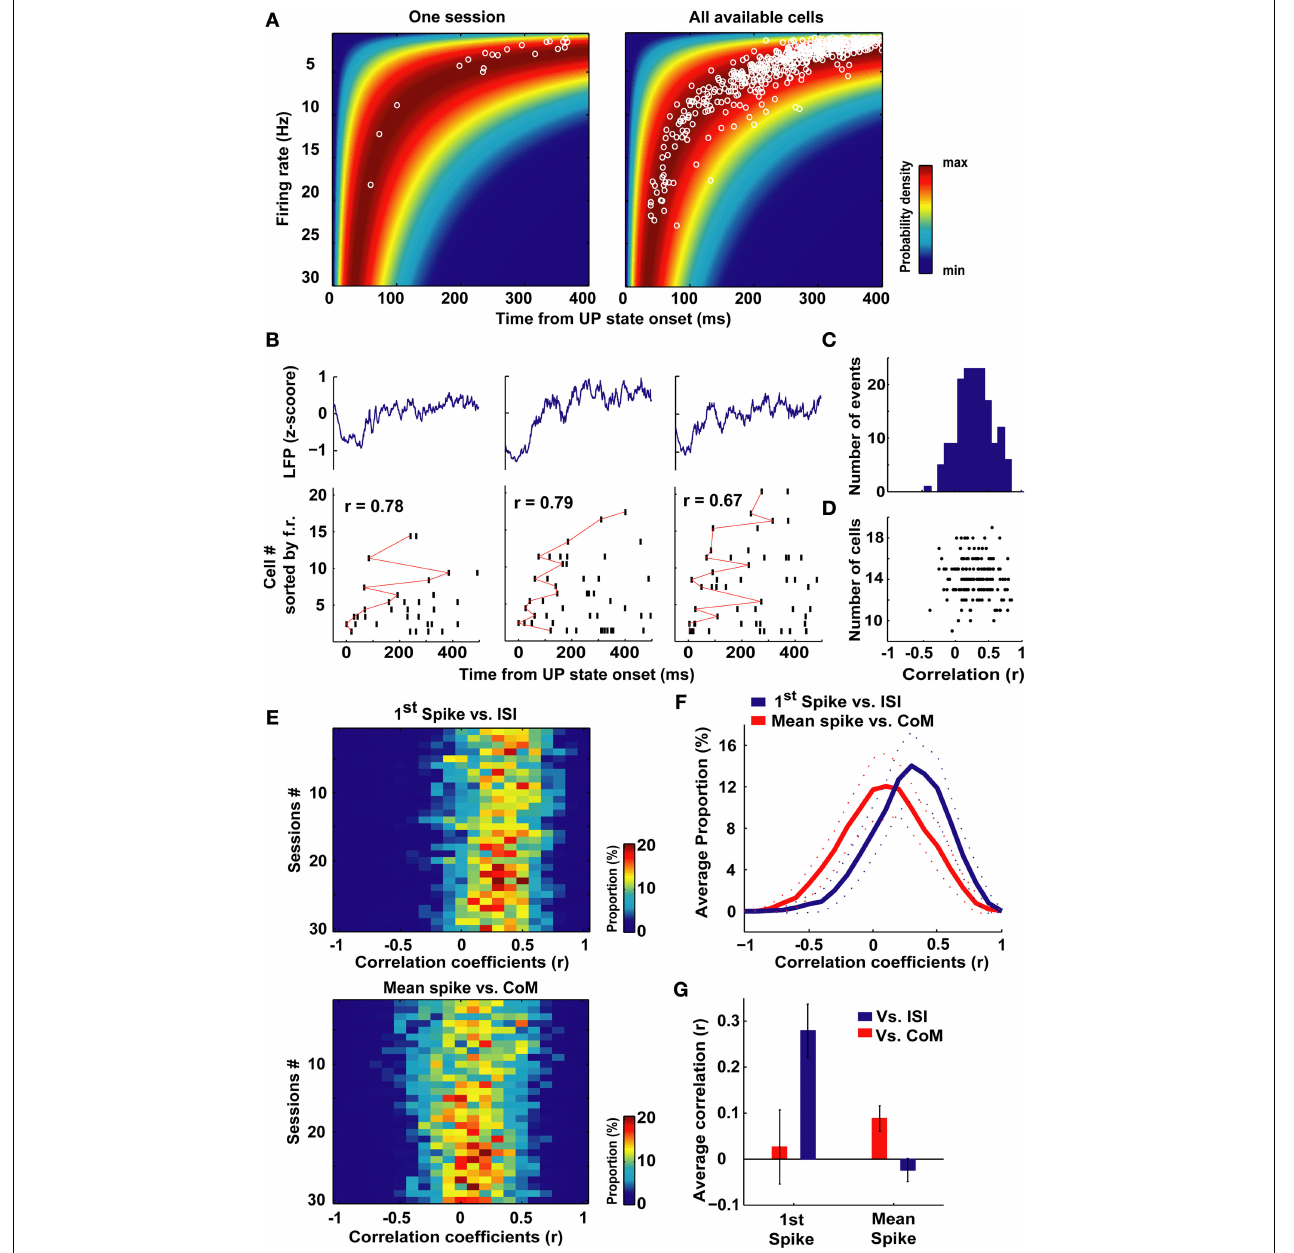
FIGURE 2 | Cell global activity level is associated with the order of fi ring. (A) The color plot indicates relative probability density of fi rst spike occurrence for a homogeneous Poisson process as a function of time elapsed (abscissa) and rate of the process. The superimposed white circles show, for each neuron, the session-averaged fi ring rate during SWS (ordinate) plotted against the averaged latency of fi rst spike occurrence at UP state onset (abscissa). Data are from a representative session (left) and from all cells analyzed (right). (B) Representative raster plots of population fi ring triggered at three different UP state onsets in a single recording session. LFPs appear above. Cells were sorted, from top to bottom, according to increasing values of session-averaged fi ring rate. Red lines connect fi rst spikes. (C) Distribution across all recorded neurons of the Spearman correlation coeffi cients between fi rst spike latencies and average fi ring rates for all the UP state onsets in which spikes were recorded from each cell. Abscissa is same as (D) . (D) Correlation coeffi cients